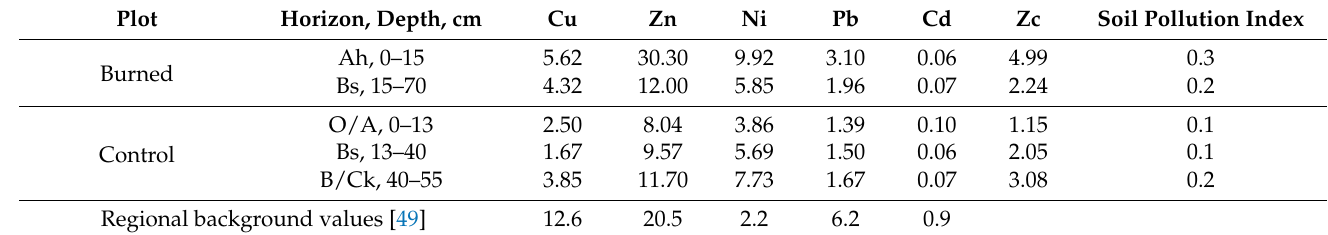
Table 3. Contents of trace metals in studied soils, mg/kg.